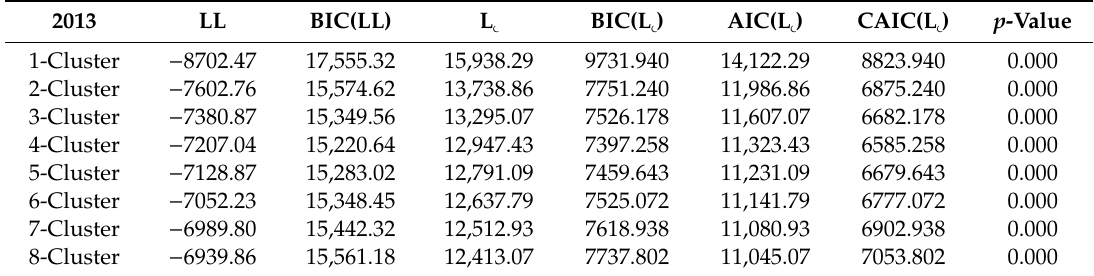
Table 2. Results of the Test for the Estimated Cluster Models in